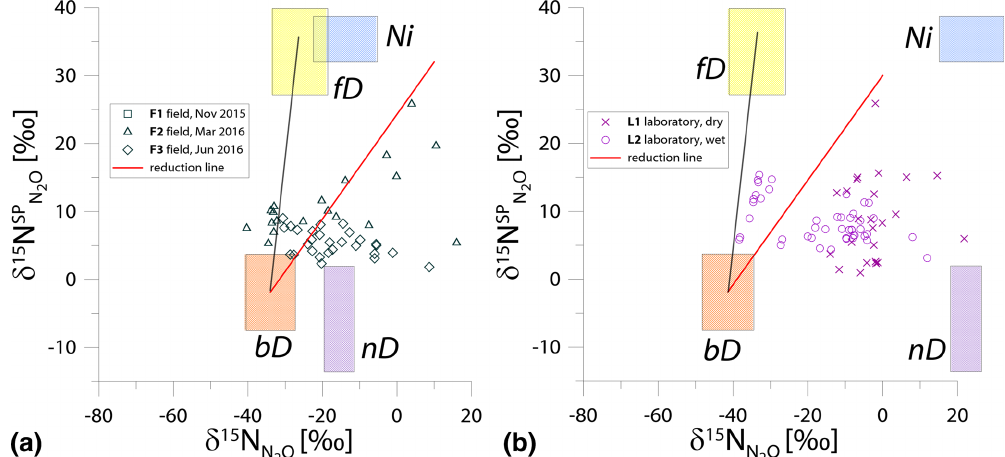
Figure 2. N 2 O isotope data of field (green points) and laboratory (purple points) in SP / N MAP presented with literature mixing endmember values and theoretical mixing (grey line) and reduction (red line) lines. δ 15 N values of mixing endmembers are presented in relation to the δ 15 N of precursors: soil nitrate for bD and fD or ammonium for nD and Ni (hence present the expected δ 15 N N pathway in these study